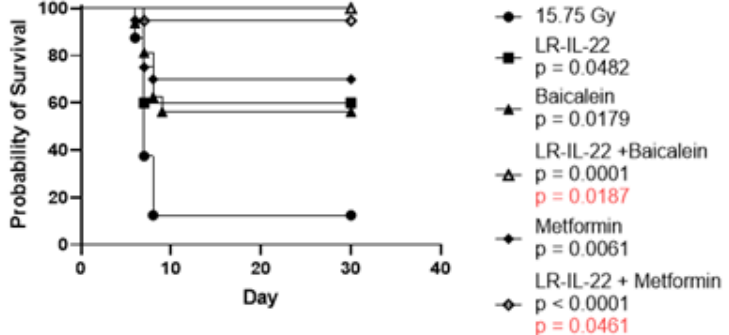
Figure 4. Improved survival of mice administered gavage of LR-IL-22 and intraperitoneal injection of small molecule radiation mitigators in C57BL/6NTac mice administered 15.75 Gy. C57BL/6NTac female mice were irradiated to 15.75 WAI. Subgroups of 20 mice each were treated with baicalein 15 min before and 24 h after WAI. Another subgroup received metformin in the drinking water for 7 days after WAI. Another subgroup was gavaged with LR-IL-22 24 h after irradiation. Other subgroups got LR-IL-22 and either baicalein or metformin as described above. The mice were followed for development of the GI syndrome at which time they were euthanized. GI syndrome is defined as death within 10 days after irradiation of greater that 12 Gy to the abdomen. P values in black are compared to 15.75 Gy WAI only while red p values are compared to baicalein only or metformin only.